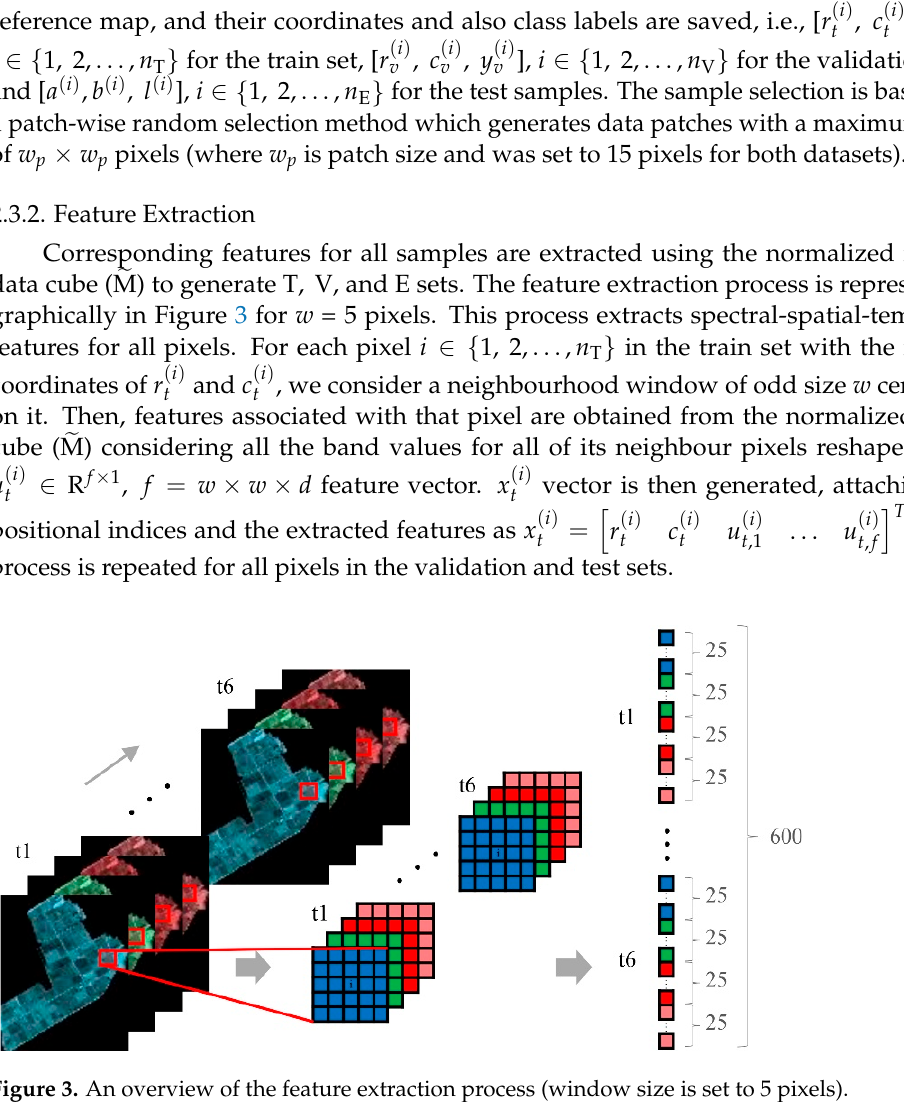
Figure 2. An overview of the proposed GFSAE classification framework.